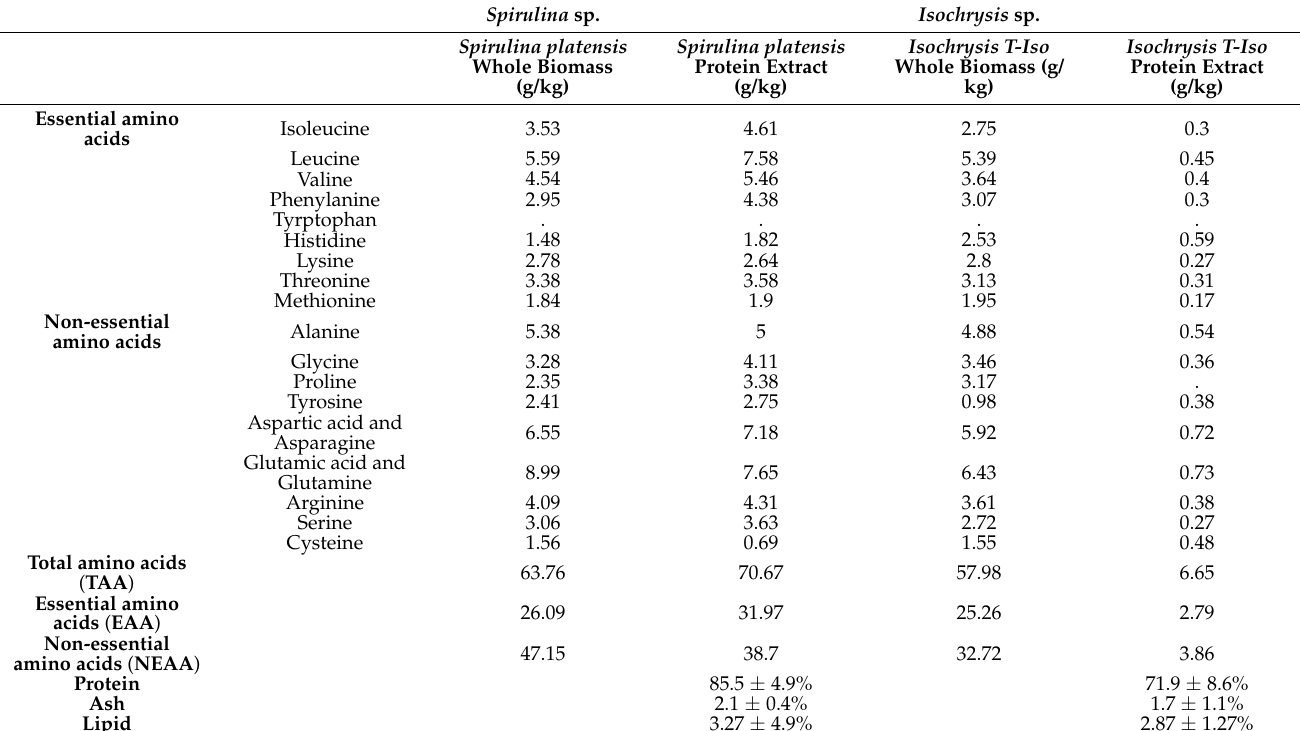
tained in both the soluble protein extracts were 14.26 µ g/mL and 9.08 µ g/mL of lysine, respectively, for the Spirulina sp. soluble protein extract and Isochrysis sp. soluble protein extract and 0.913 µ g/mL and 0.57 µ g/mL of methionine, respectively. The Spirulina sp. soluble protein extracts contained less methionine and lysine than previously reported by Liestianty et al. [25], who reported methionine and lysine contents of 14 mg g − 1 (me- thionine) and 30 mg g − 1 (lysine). The free amino acid contents of both microalga protein extracts are shown in Table 2. Table 1. Proximate analysis and total amino acid content of the microalgal protein extracts. Spirulina sp. Isochrysis sp. Spirulina platensis Whole Biomass